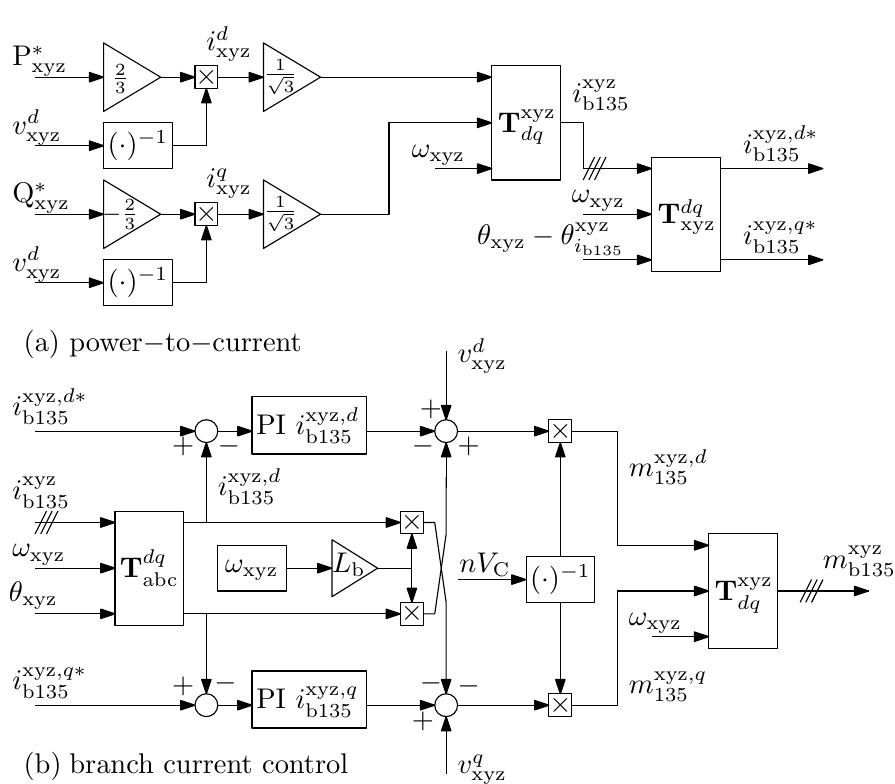
Figure 2. Block diagrams of current control to determine m xyz